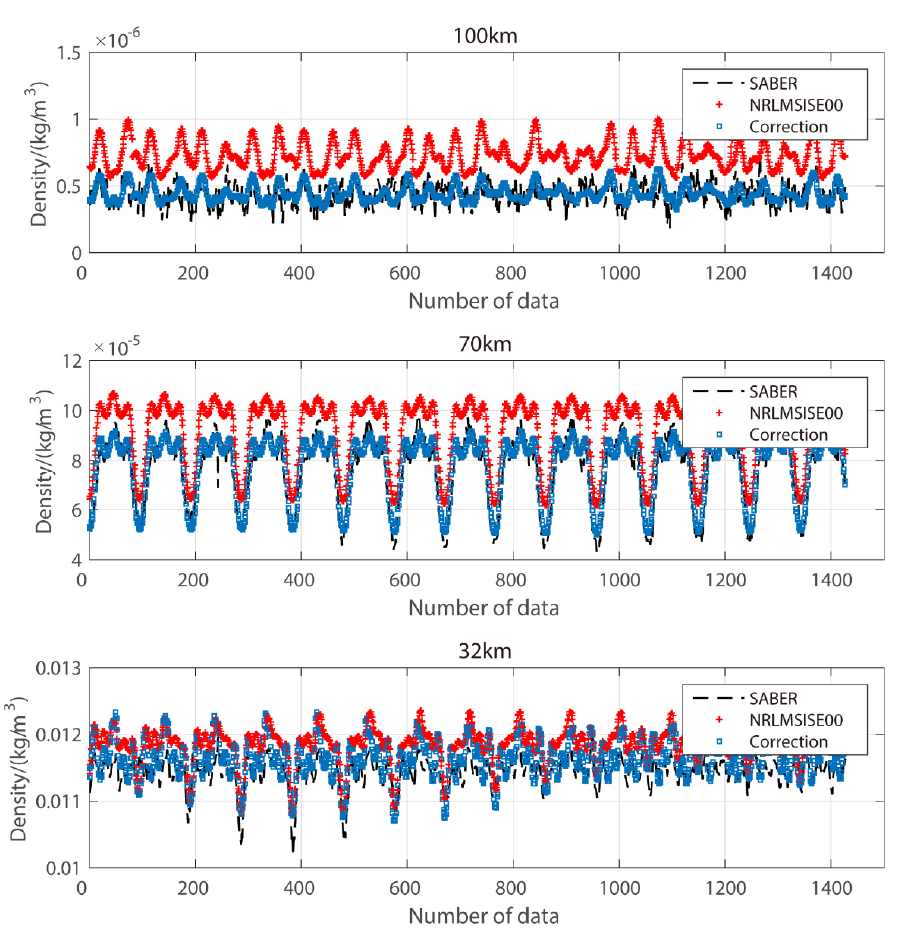
Figure 8. Same as Figure 7 but for day 129 of 2017. Table 3. Atmospheric density error on satellite orbits at different nodes on day 129 of 2017 (%). 100